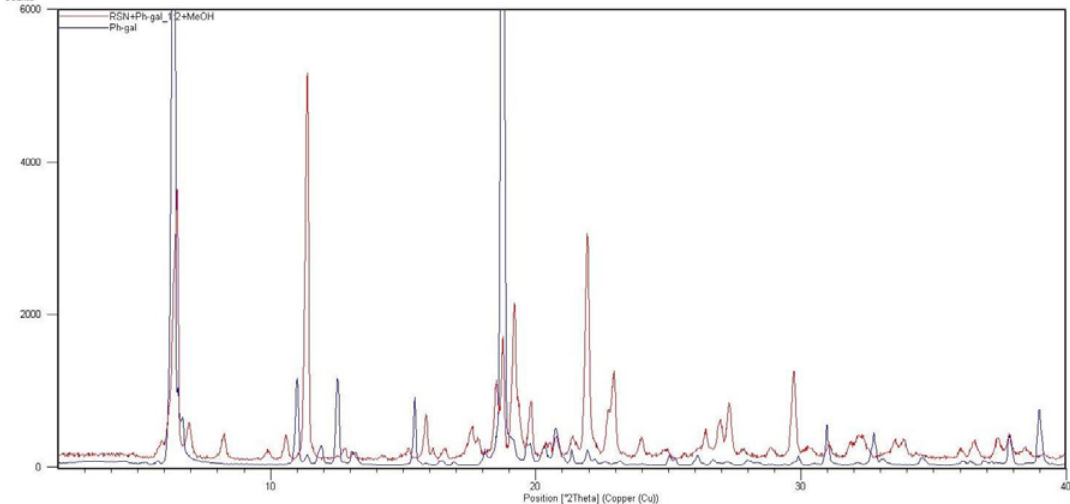
Figure 17. XRPD patterns of sample 6 (RSN+phenyl- D -galactopyranoside in ratio 1:2) and phenyl- β - D -galactopyranoside